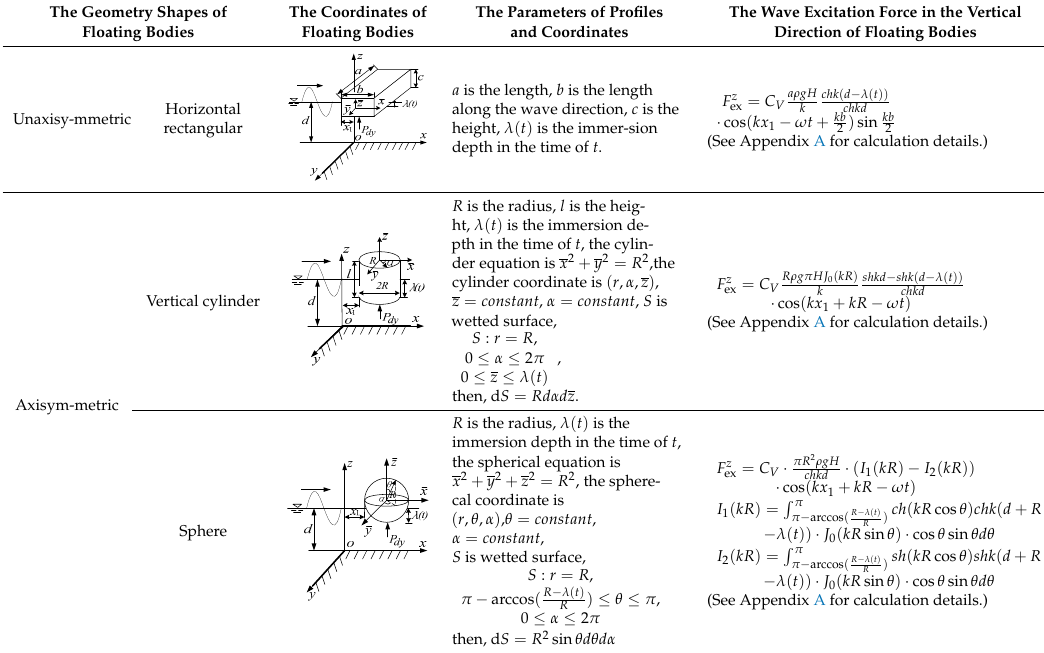
Table 1. The algebraic solutions of the wave excitation force in the vertical direction of multi-type floating bodies.